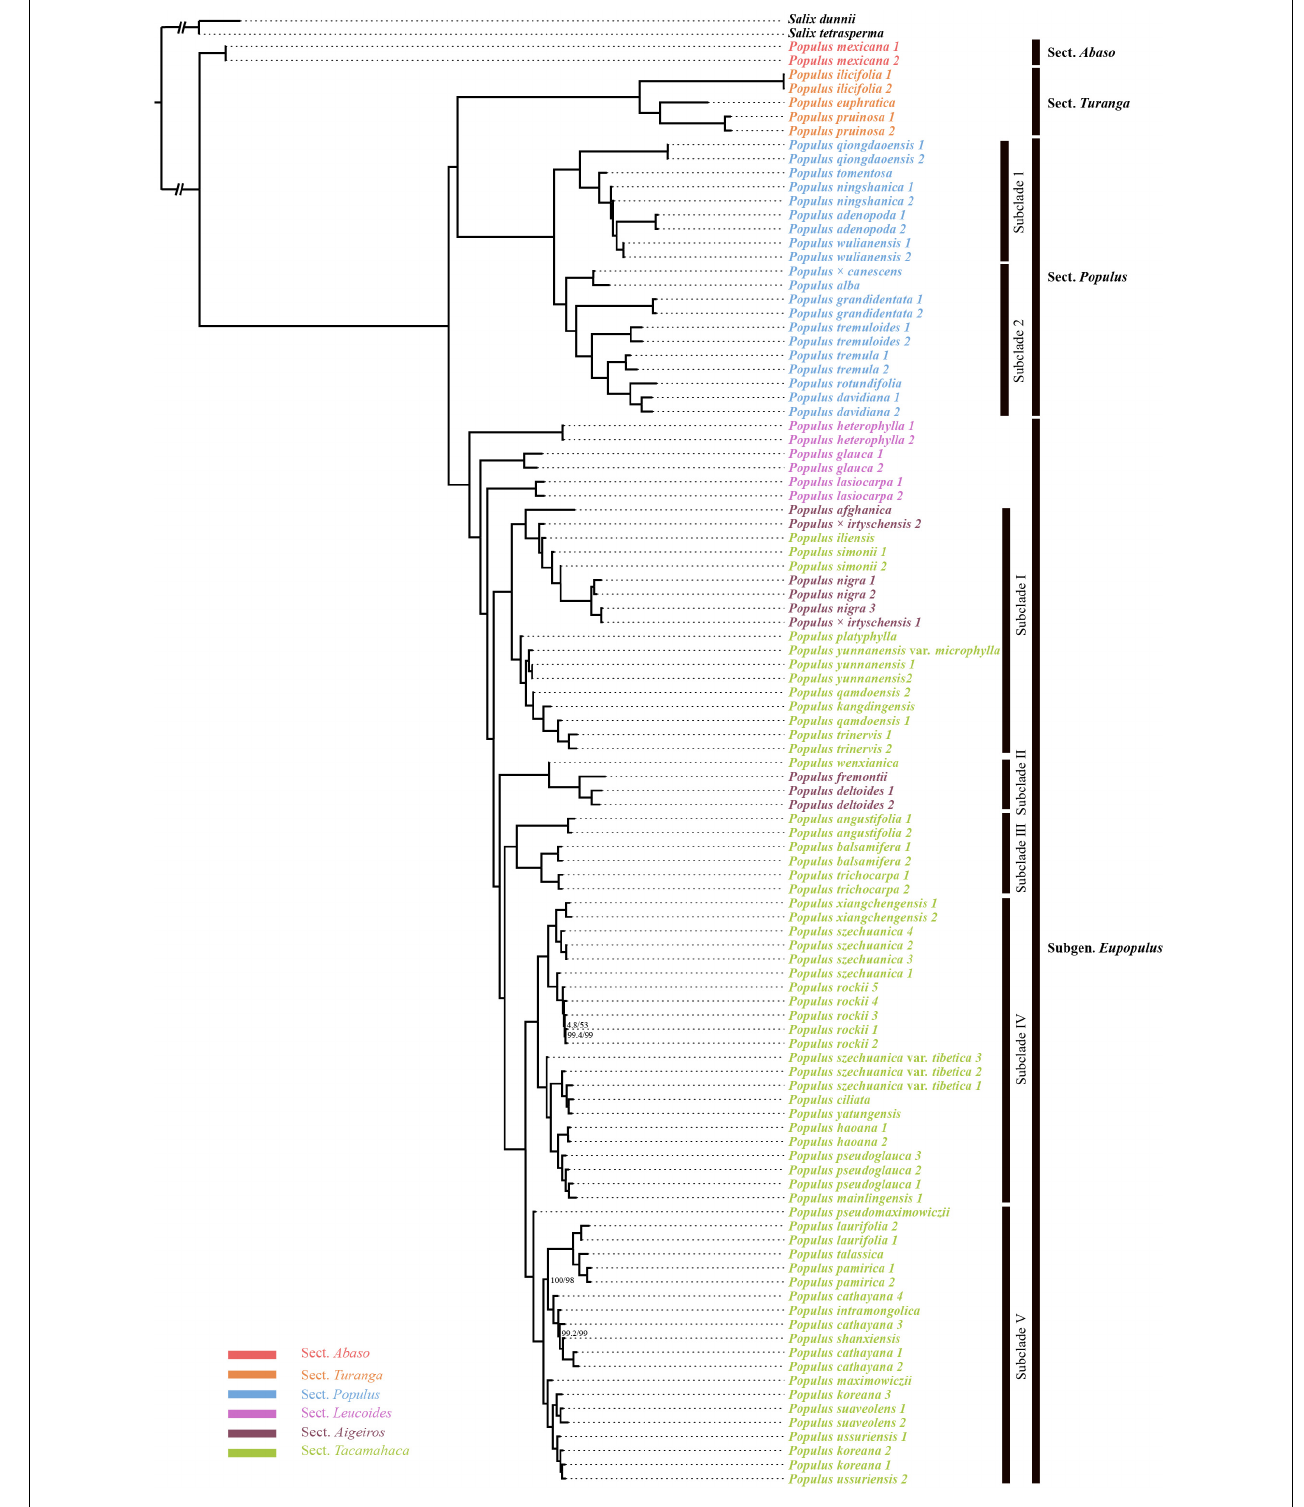
FIGURE 1 | Phylogenetic relationship of the genus Populus reconstructed by IQ-TREE based on 12,916,788 nuclear SNPs. Unless otherwise indicated, all nodes had 100% supports of SH-aLRT bootstrap (Alrt) and Ultrafast bootstrap (UFBoot).